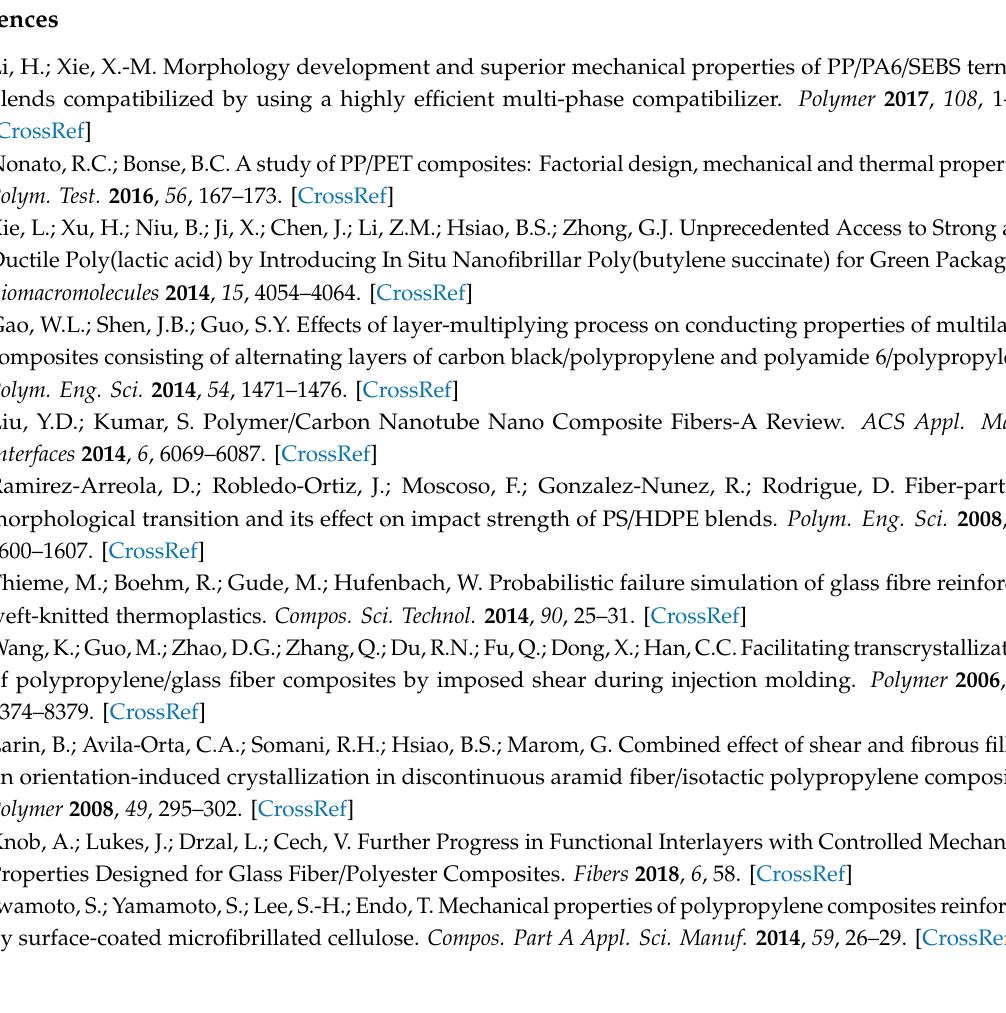
Table S1: Parameters of the pure PP and the PP / PA6 blends with di ff erent stretch ratios for the lattice planes (110) of the PP α -crystals from WAXS patterns. Table S2: Parameters of the pure PP and the PP / PA6 blends with di ff erent stretch ratios for the lattice planes (040) of the PP α -crystals from WAXS